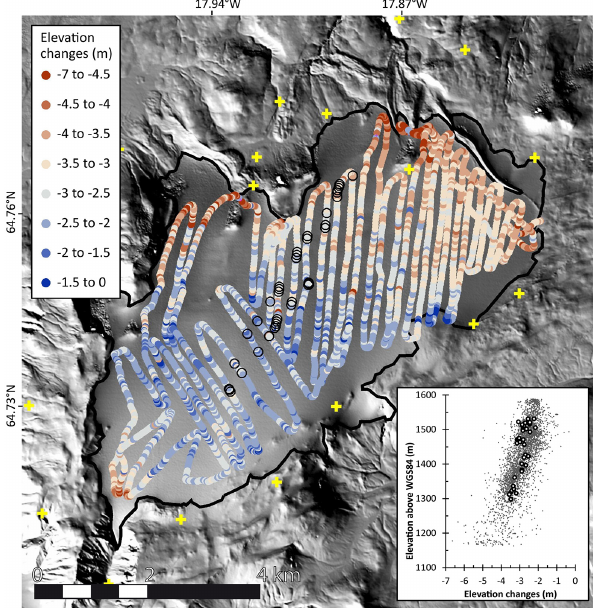
Figure 6. Elevation differences between the kinematic GNSS data (2 May 2013) and the Pléiades DEM (9 October 2013) on the Tung- nafellsjökull ice cap. Black circles indicate the locations where el- evation differences have been measured using repeated GNSS sur- veys (2 May 2013 and 18 September 2013). Yellow crosses show the location of most of the 19 GCPs used to generate the DEM (two are masked by the inset and the colour scale). Inset: distribution of these elevation differences with altitude, with repeat GNSS surveys shown as larger dots. Background: shaded relief image derived from the Pléiades